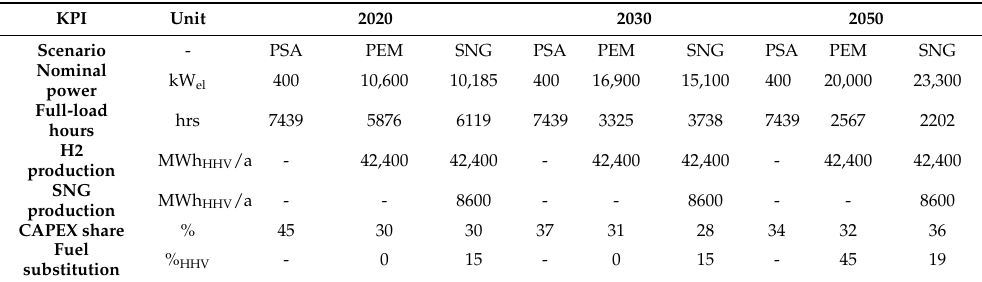
Table 5. Resulting key performance indicators for the optimization